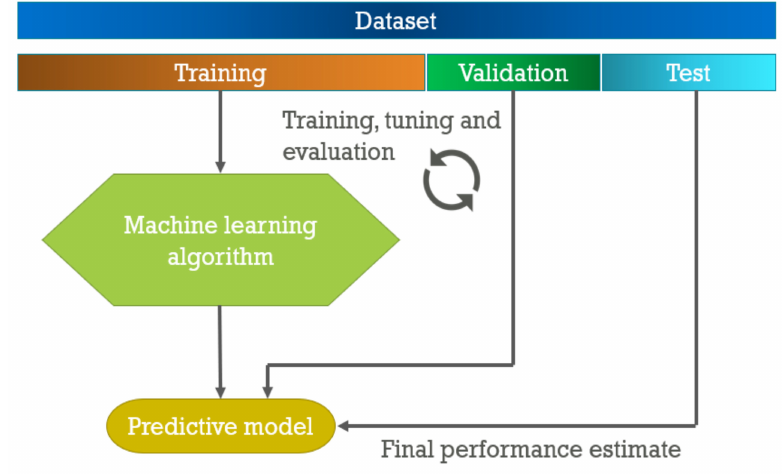
Figure 2. Basic steps of the AI/ML